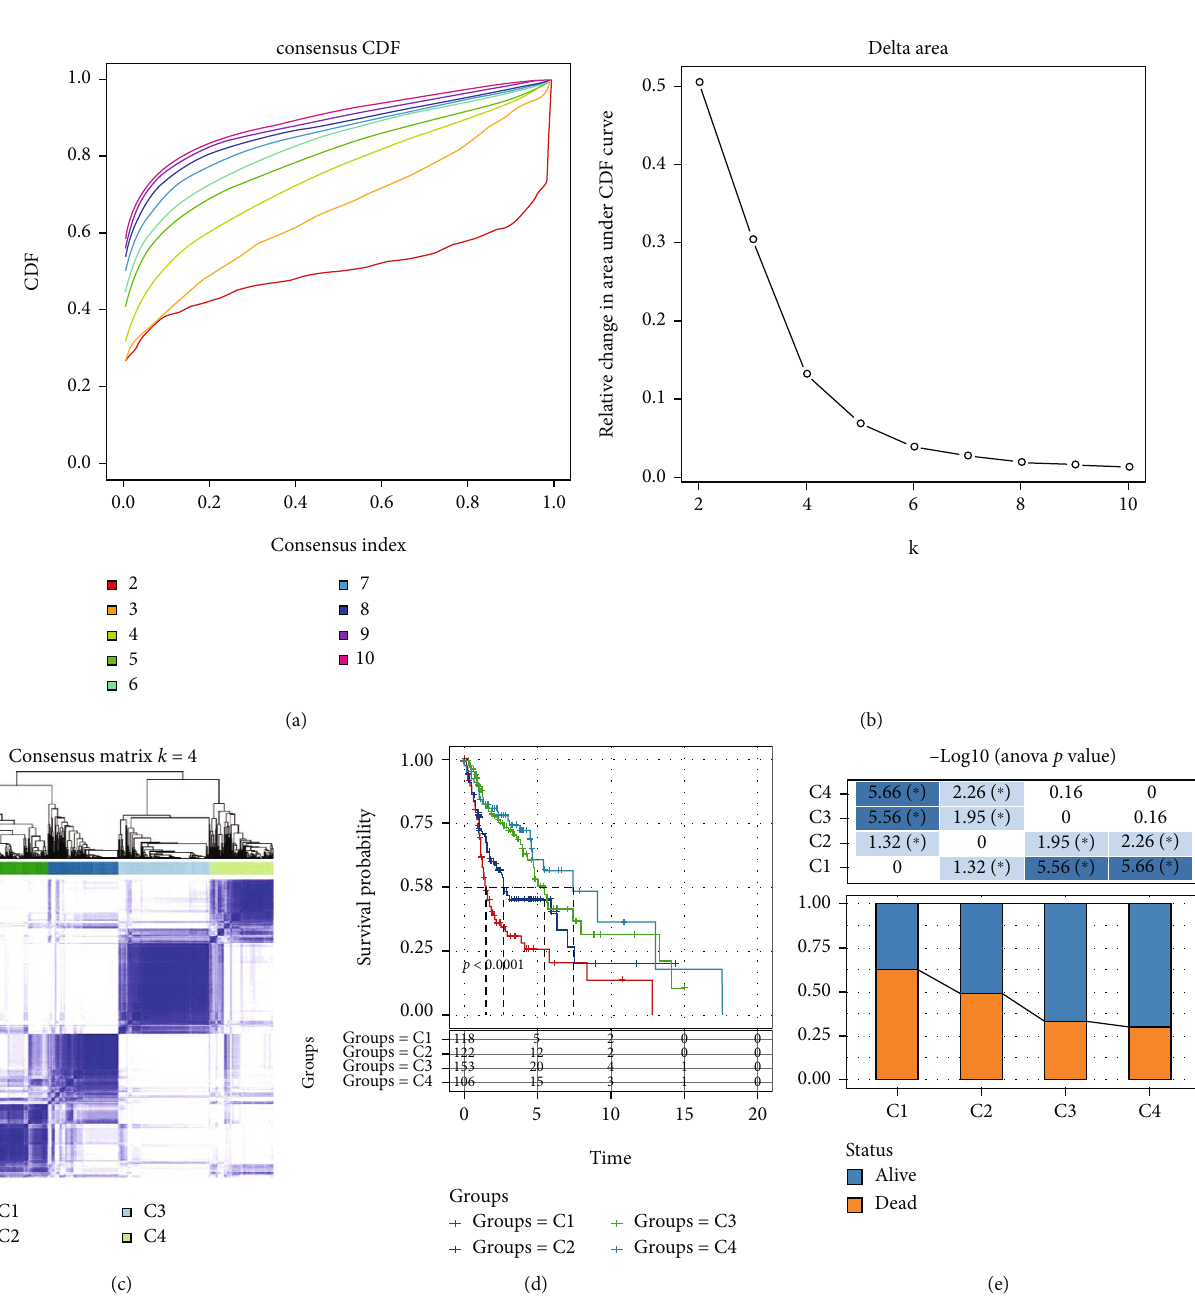
Figure 1: The TCGA cohort molecular typing based on cellular senescence-associated genes. (a) CDF curve for TCGA cohort samples. (b) CDF delta area curve for TCGA cohort samples. The vertical axis represents the relative change in area under CDF curve, and the horizontal axis represents the category number k . (c) At consensus k = 4 , heat map of sample clustering. (d) KM curve of the four subtypes. (e) Survival status di ff erences in di ff erent subtypes. ∗ P < 0 : 05